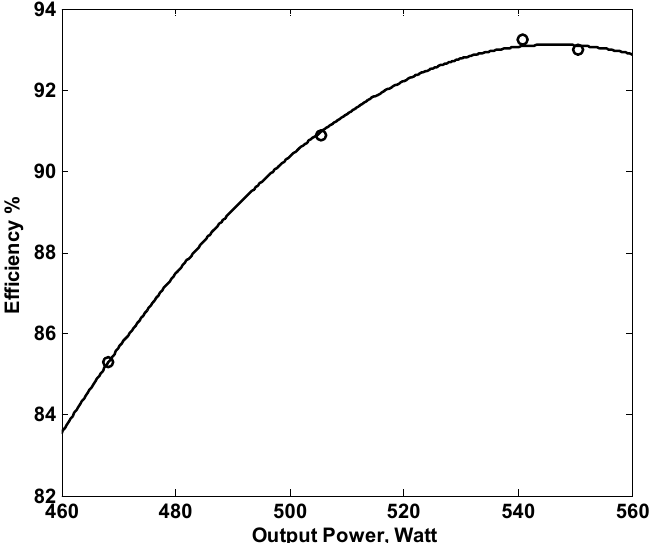
Figure 38. Efficiency variation with output power, duty ratio = 0.5, and the load is variable resistive. Considering the closed-loop control, a voltage transducer is used to measure the voltage at the load terminals. The reference voltage is set at 50 V. Figure 39 shows